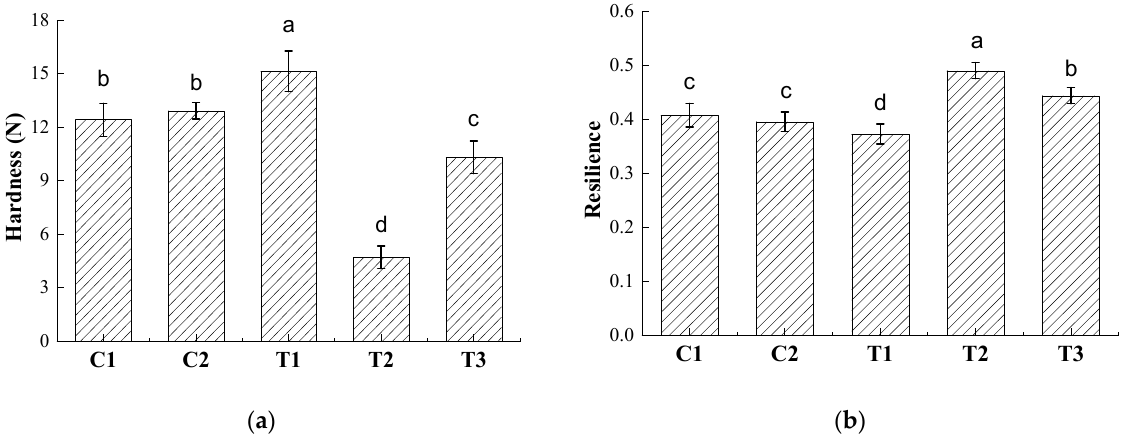
Figure 2. Hardness ( a ) and resilience ( b ) of breads with different treatments with different letters denoting statistical differences ( p < 0.05) among treatments ( n = 6).